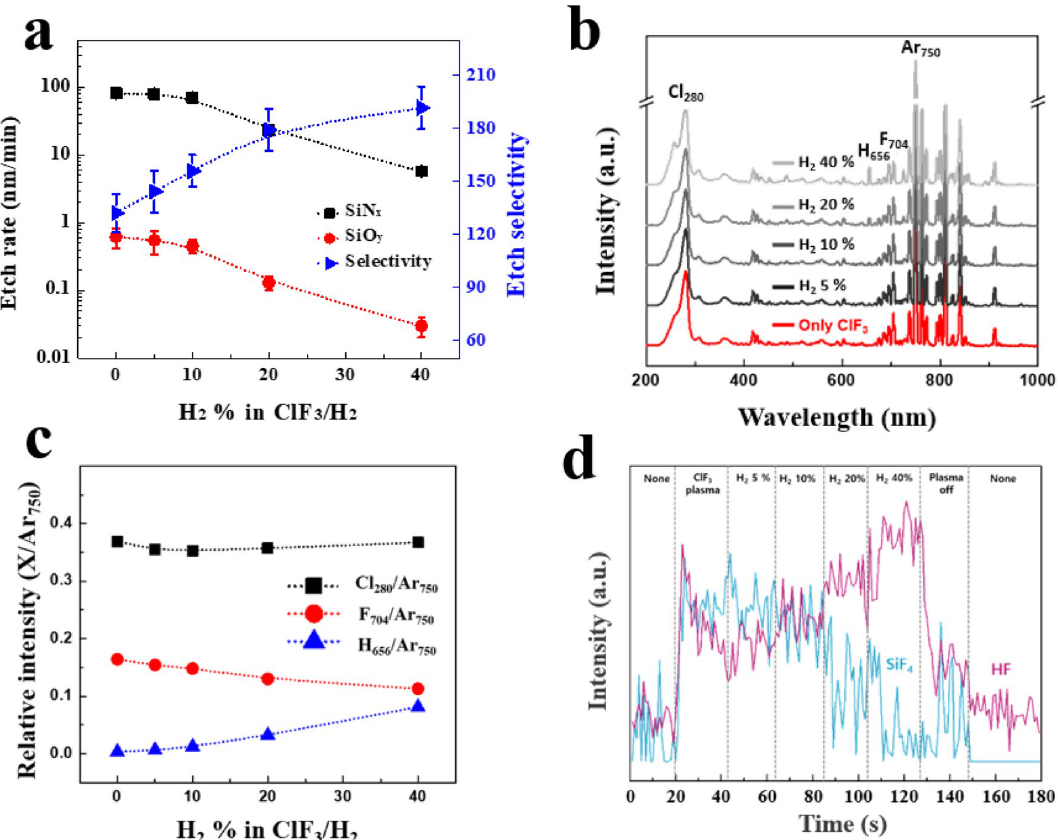
Figure 3. ( a ) Etch characteristics of SiN x and SiO y with ClF 3 /H 2 plasma as a function of H 2 percentage in ClF 3 / H 2 . ( b ) OES data of ClF 3 /H 2 /Ar plasma with different H 2 percentage in ClF 3 /H 2 . ( c ) optical emission intensities of Cl, F, and H normalized by the intensity of Ar (750 nm) in ( b ) plotted as a function of H 2 percentage. ( d ) FTIR data of ClF 3 /H 2 plasma during SiN x etching. For ClF 3 /H 2 remote plasmas, 200 sccm of Ar was added for the plasma